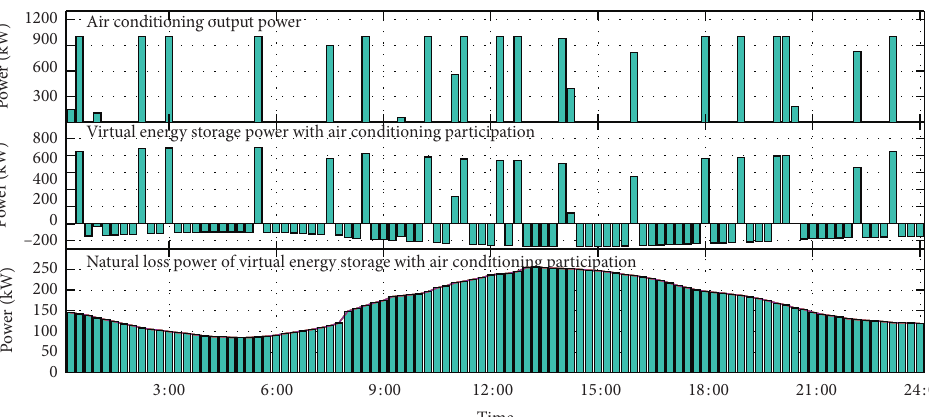
Figure 14: Comparison chart of the natural power consumption of the virtual energy storage with air conditioning participation, air conditioning power, and virtual power of virtual energy storage.